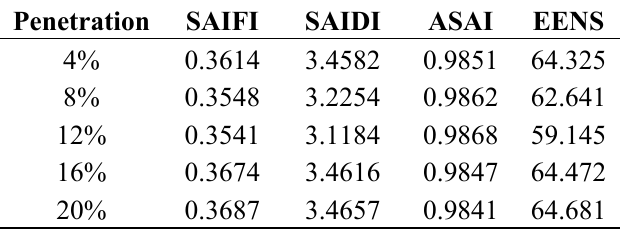
Table 3. System reliability index comparison on different penetration of